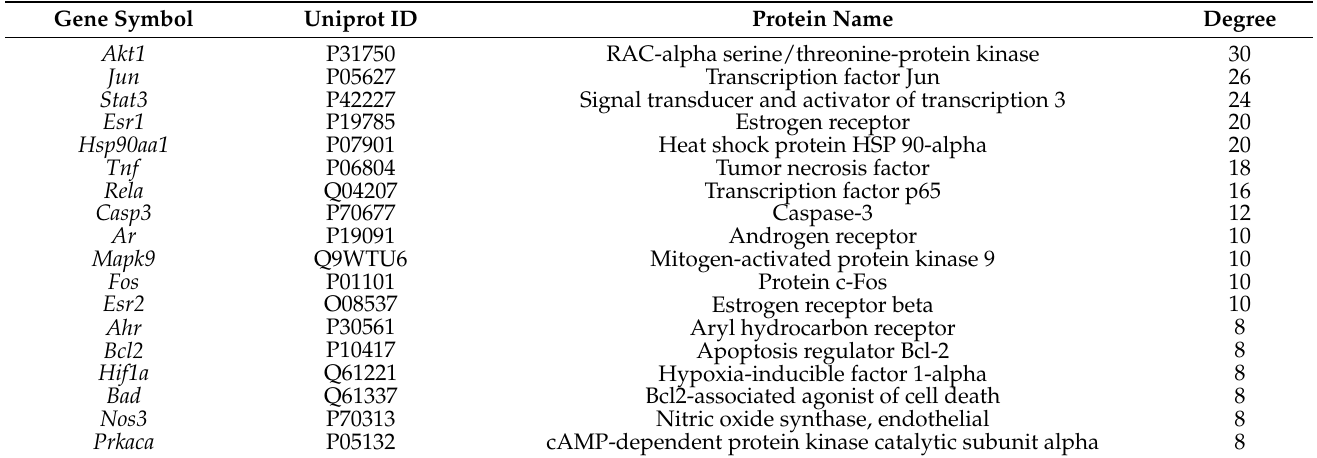
Figure 2. The network pharmacology analysis of puerarin anti-inflammatory. ( A ) The potential targets of puerarin countering inflammation and PPI network of 51 targets. ( B ) Bubble diagram of the top20 KEGG pathways. Table 1. The 18 common protein targets information of puerarin